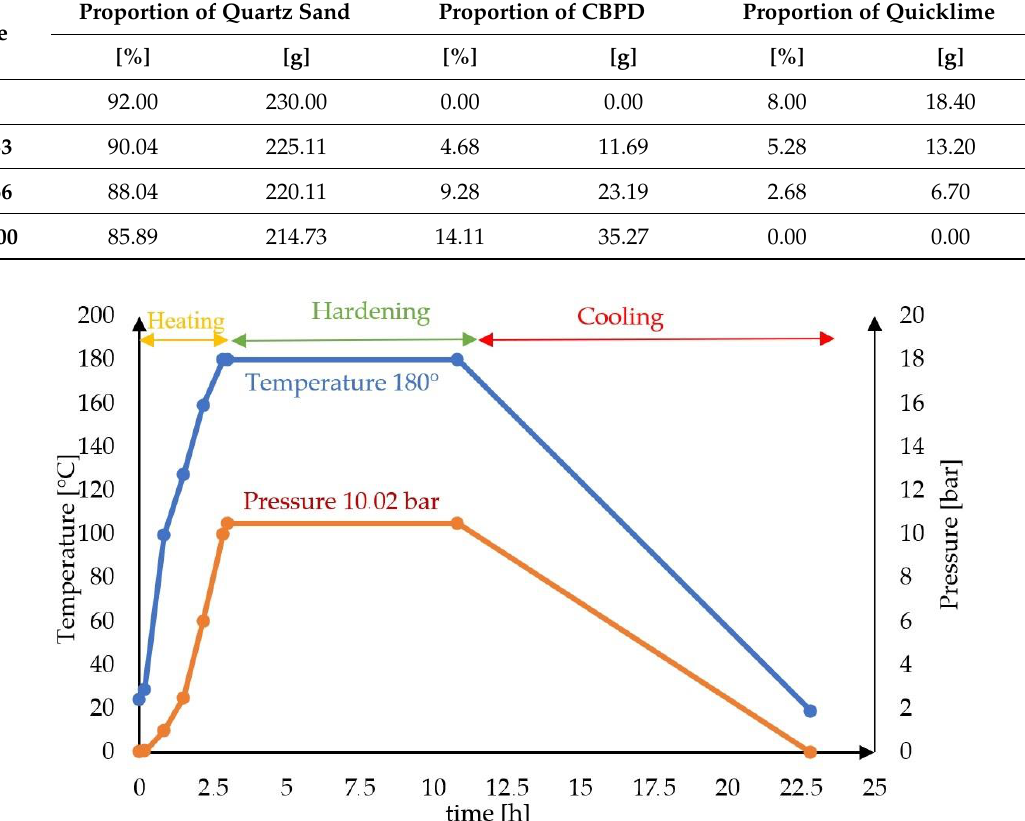
Figure 3. Autoclaving process as a function of time.